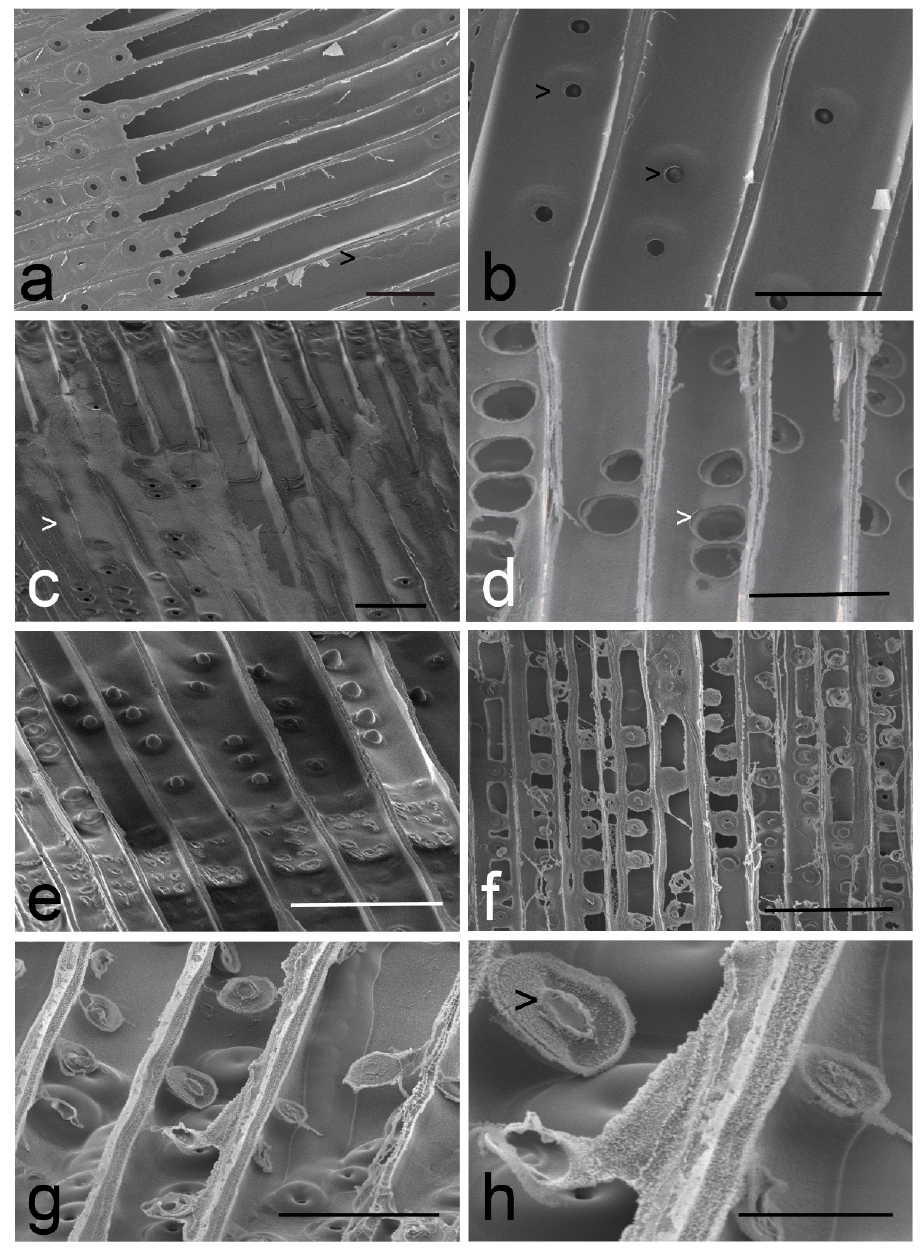
Figure 2. SEM photomicrographs of blue-stained lodgepole pine wood before and after hot-oil modification and plasma treatment: ( a ) and ( b ) Unmodified controls; ( c ) Wood modified with hot-oil; ( d ) Unmodified wood treated with plasma for 667 s; ( e ) Hot-oil modified wood treated with plasma for 333 s. Note the ballooning of pit membranes through the aperture of the bordered pits; ( f – h ) Hot-oil modified wood treated with plasma for 1333 s.